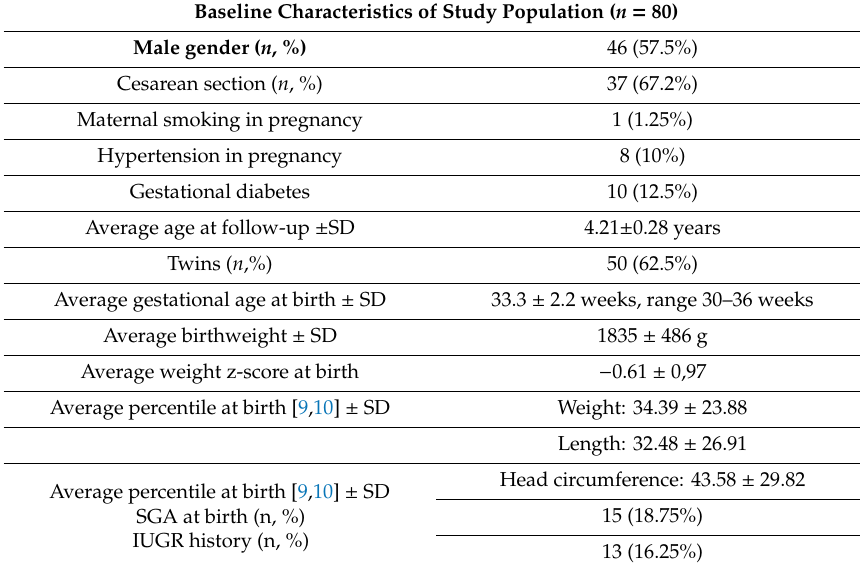
Table 1. Baseline